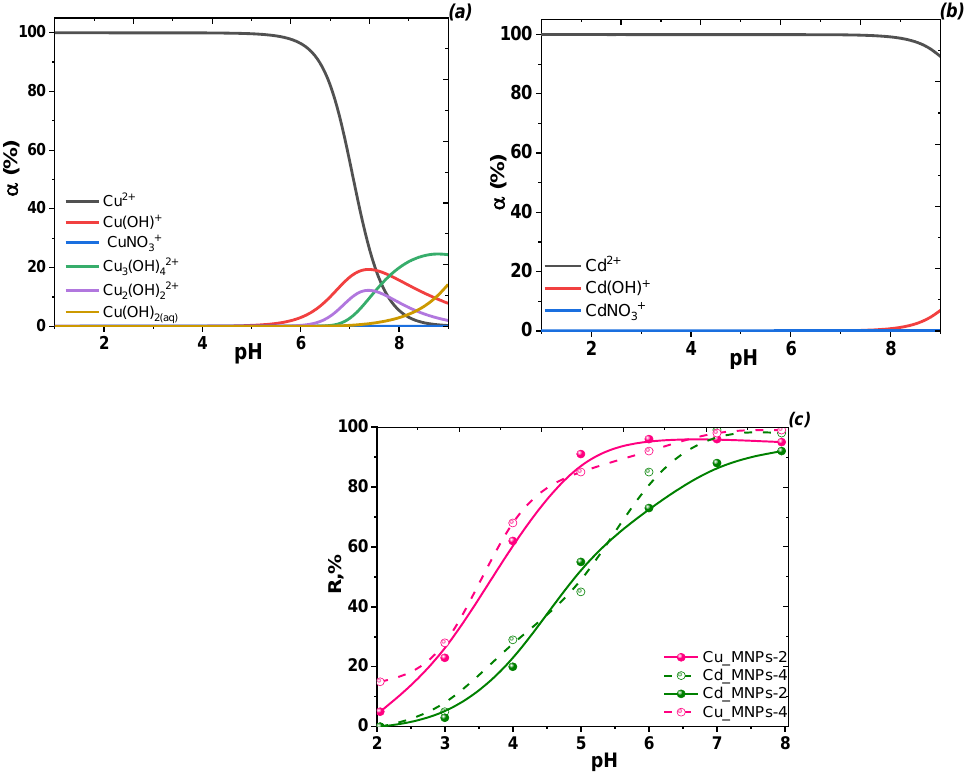
Figure 10. Effect of pH on the distribution forms of Cu(II) ( a ) and Cd(II) ( b ) in aqueous solution and its removal by MNPs ( c ) (Conditions: C(Cu(II)) = C(Cd(II)) = 0.001 M (64.5 mg/L and 236.4 mg/L, respectively), adsorbent dose 50 mg, volume 15 mL, contact time 1 h, ambient temperature (20 ± 2 °C)).